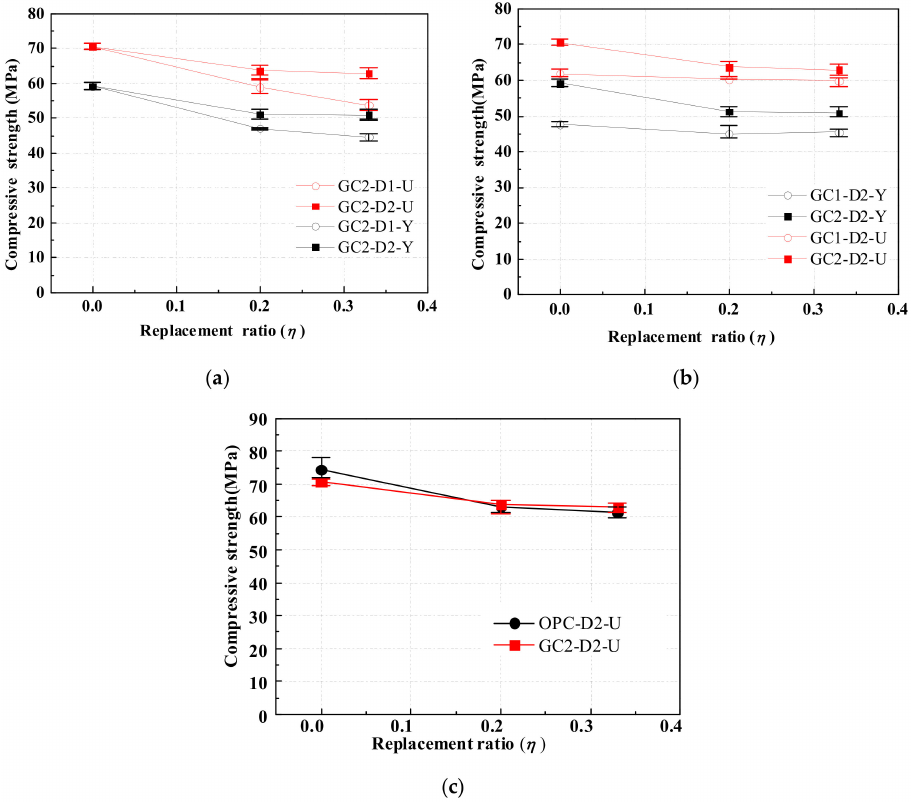
Figure 7. E ff ect of strength levels of demolished concrete lumps (DCLs) and fresh concrete, and type of fresh concrete on compressive strength of RLC. ( a ) Di ff erent strength levels of DCLs. ( b ) Di ff erent strength level of fresh GC. ( c ) Di ff erent types of fresh concrete.